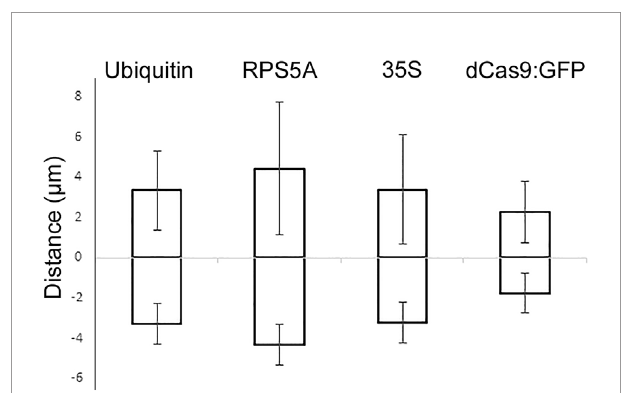
FIGURE 9 | Measurement of inter-telomeric distance changes in nuclei transformed with three different indirectly labeled aptamer-dCas9 which were under the control of ubiquitin, RPS5a or 35S promoters and directly labeled dCas9 which was under the control of the ubiquitin promoter. Intra-telomeric distance changes vary between minimum ±1 µm to maximum ±4